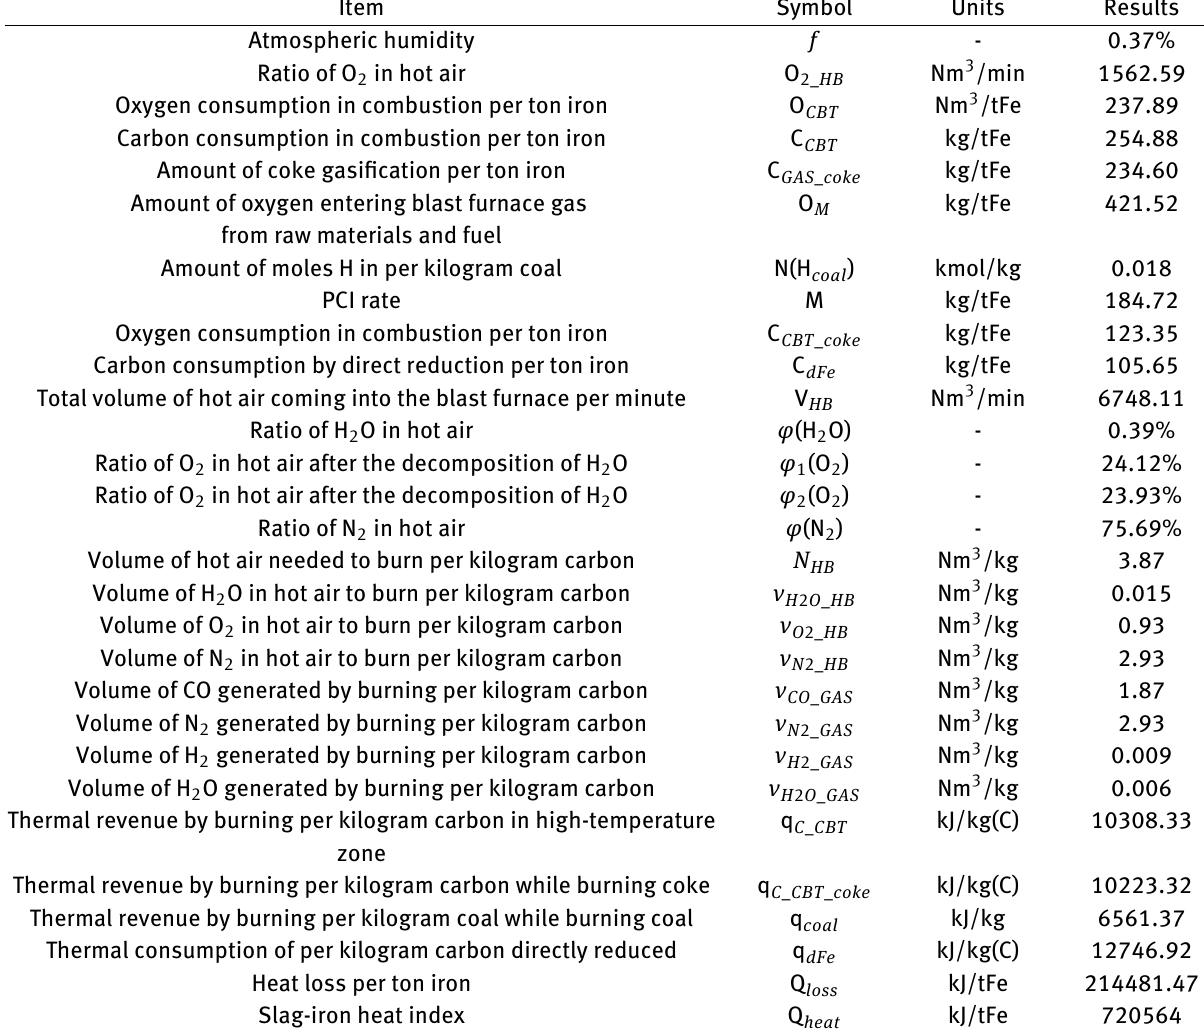
Table 2: Heat calculation results of blast furnace.